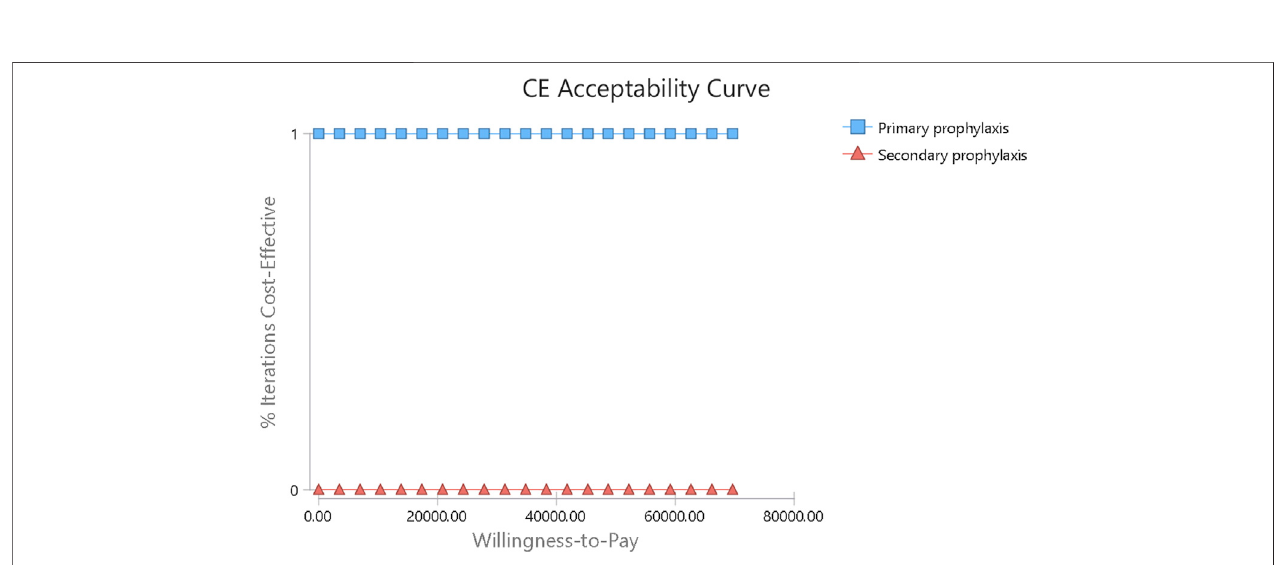
FIGURE 3 | Acceptability curve for PEG-rhG-CSF primary versus secondary prophylaxis.